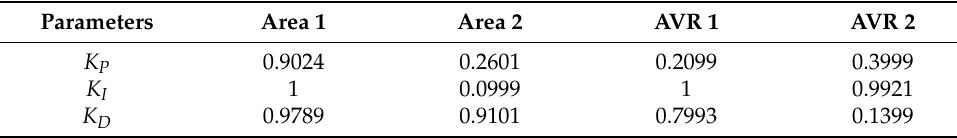
Table 2. PID parameters.